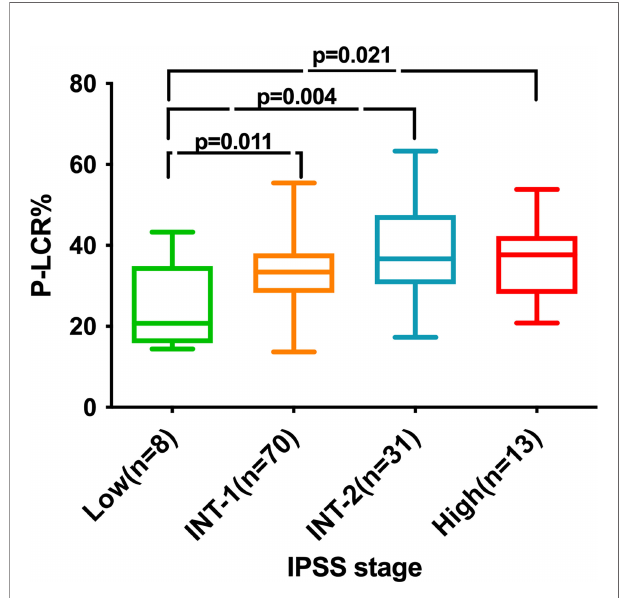
FIGURE 1 | P-LCR level of 122 MDS patients at diagnosis according to the